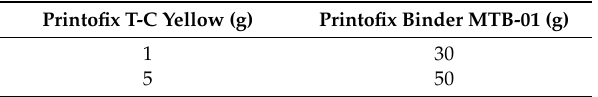
Table 2. Mixing of pigment and binder in 1 litre of deionised